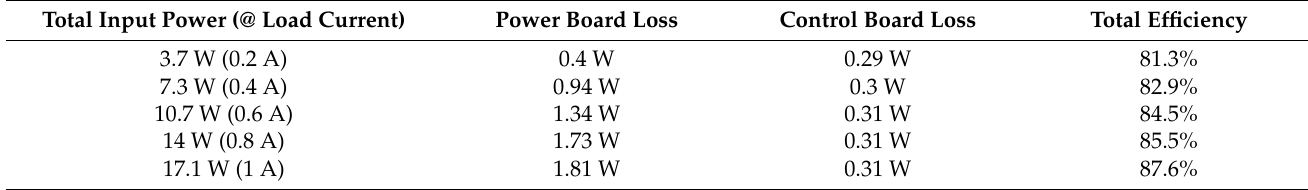
Table 3. Loss and efficiency test results at light load.